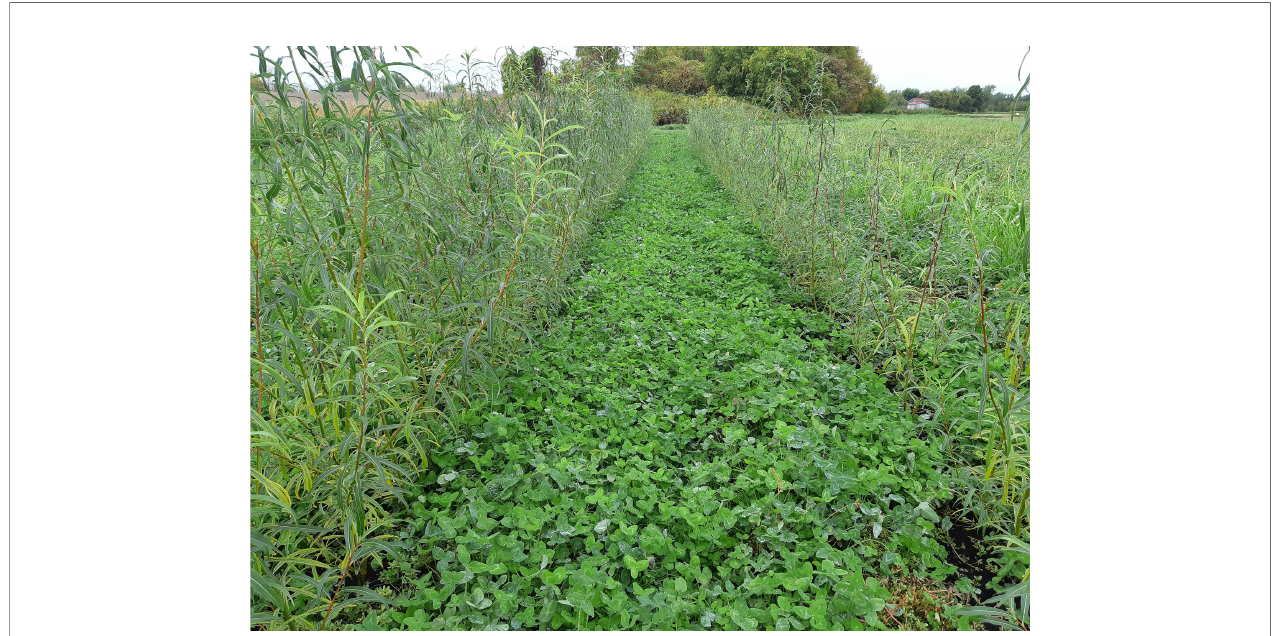
FIGURE 4 | Willow fi eld intercropped with red clover. Photo credit: Jacynthe Dessureault-Rompre ́